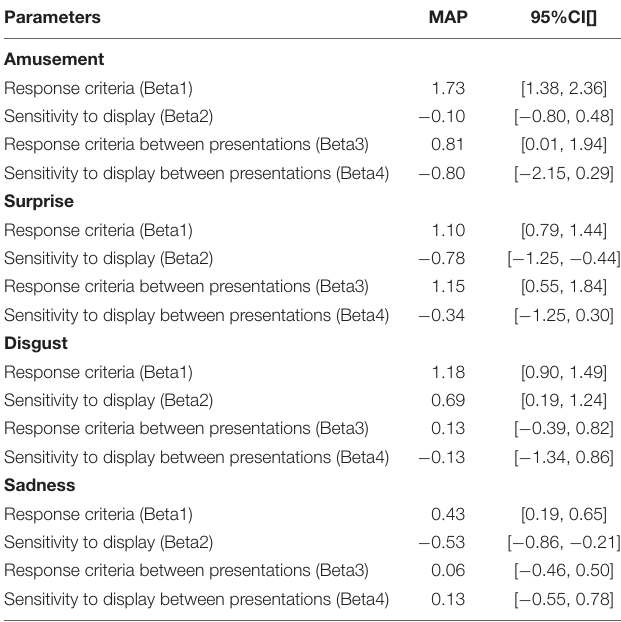
TABLE 3 | Estimated parameters on show condition across each emotion using a Bayesian signal detection